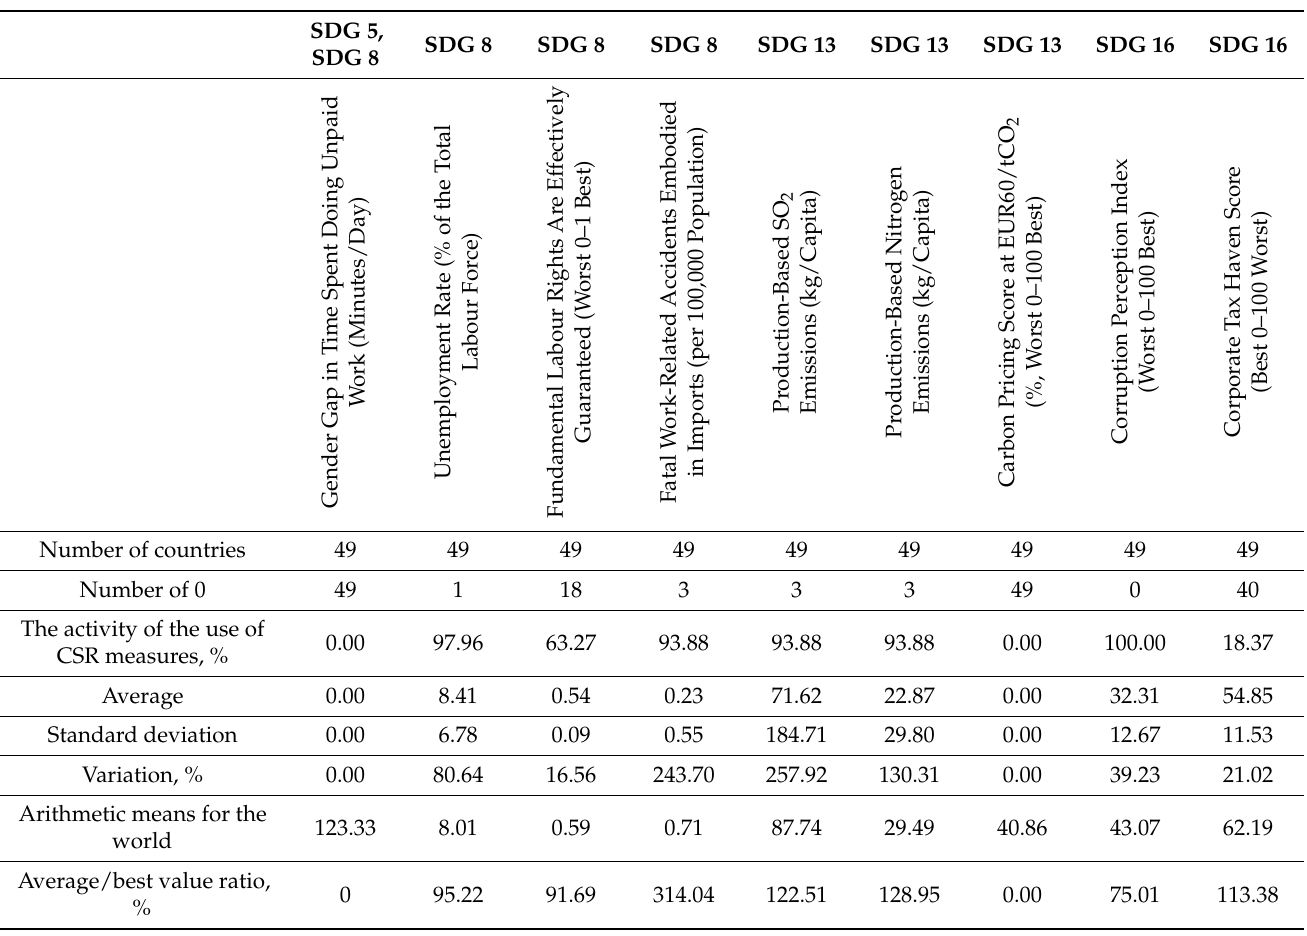
Table 4. Representation of the CSR practices to support the SDGs (UN standards) in countries of Africa in 2021.